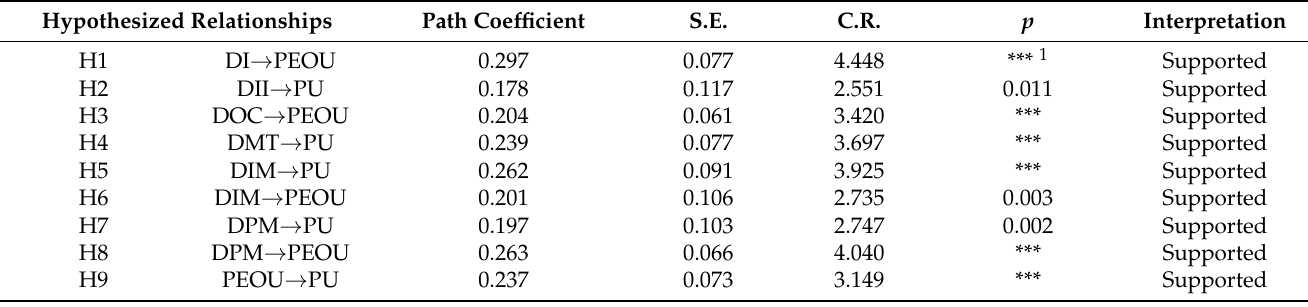
Table 6. Result of path analysis.